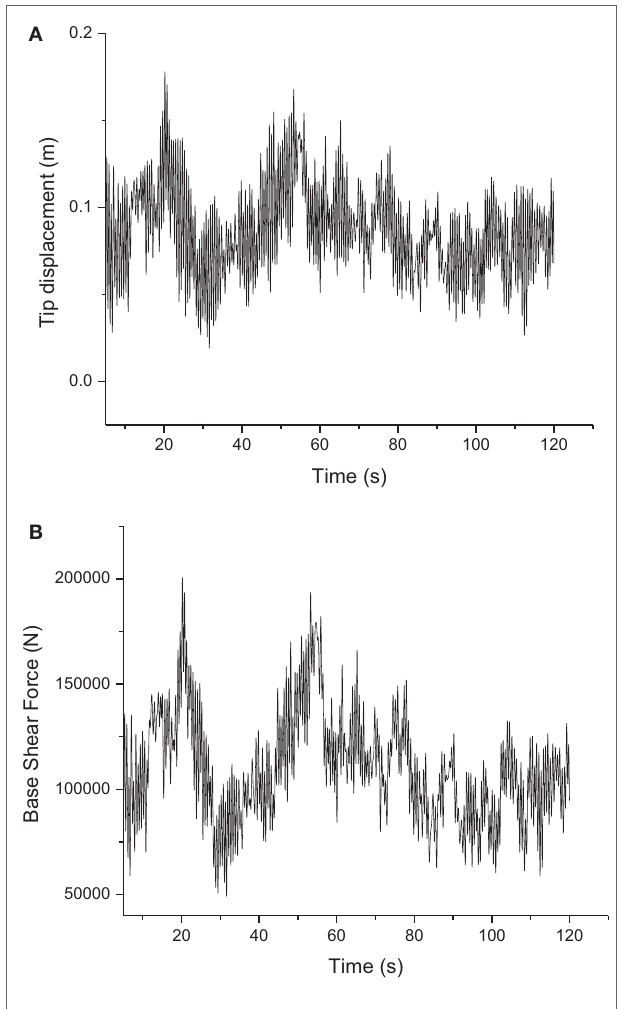
FigUre 10 | Time history for top tip displacement and base shear force . (a) Top tip displacement. (B) Base shear